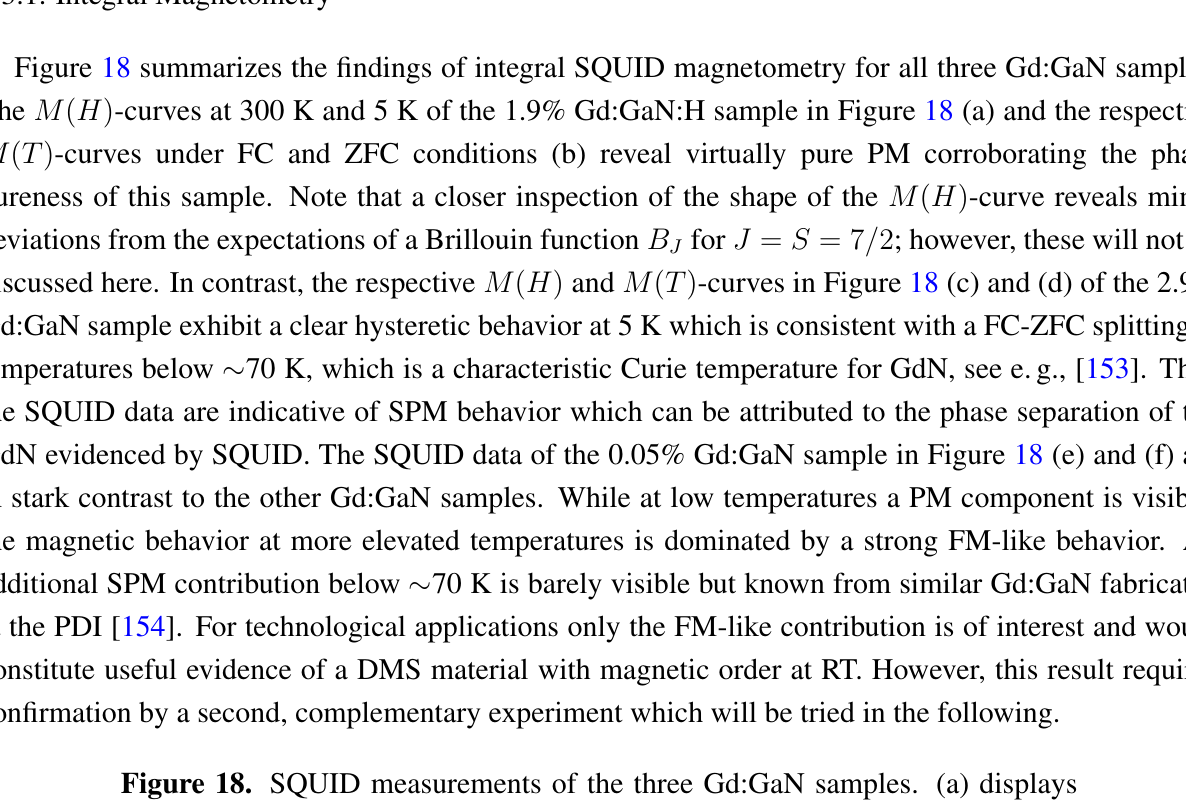
Figure 18. SQUID measurements of the three Gd:GaN samples. (a) displays M ( H ) -curves at 300 K and 5 K and (b) the respective M ( T ) in FC and ZFC conditions of the 1.9% Gd:GaN sample revealing PM. (c) and (d) display the respective data of the 2.9% Gd:GaN sample; the inset in (c) enlarges the low field regime. (e) and (f) collate the SQUID data of the 0.05% Gd:GaN sample. All data are normalized to M (5 K, 4 T ) and the diamagnetic background of the substrate has been derived from the high-field behavior of the 300 K data and subtracted from all data